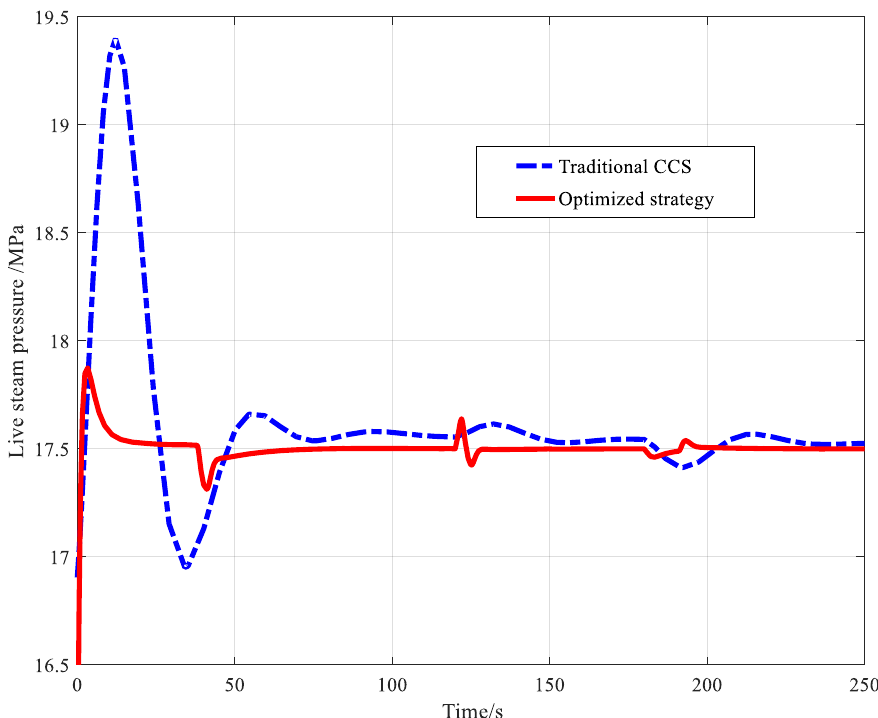
Figure 7. Response curves of live steam pressure with power step input by two different strategies.